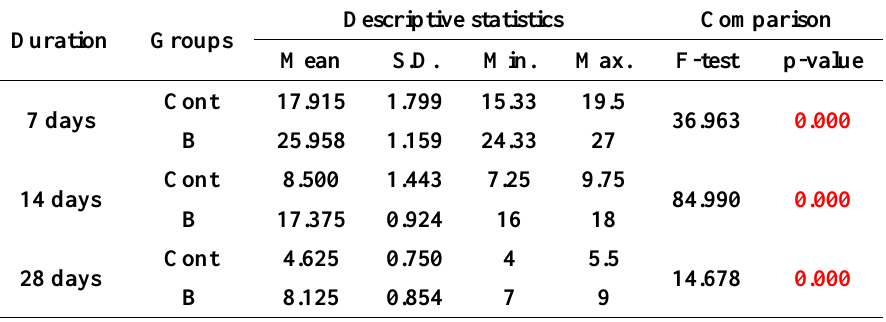
Figure (4) : Immunohistochemical view shows Figure (3) : View of 4 weeks duration of control positive BSP expression in osteoid tissue(OT) in group showed mature bone contain positive bone sialoprotein group 7 days with negative expressed of osteocytes(arrow heads), osteoblast expression in basal bone (BB) . DAB (arrow) and osteoclast ( red arrow).DAB stain with counter stain hematoxylin x40 Table (1) : Descriptive statistics of the positive stromal cells expressed by bone sialoprotein and groups’ difference in each duration.